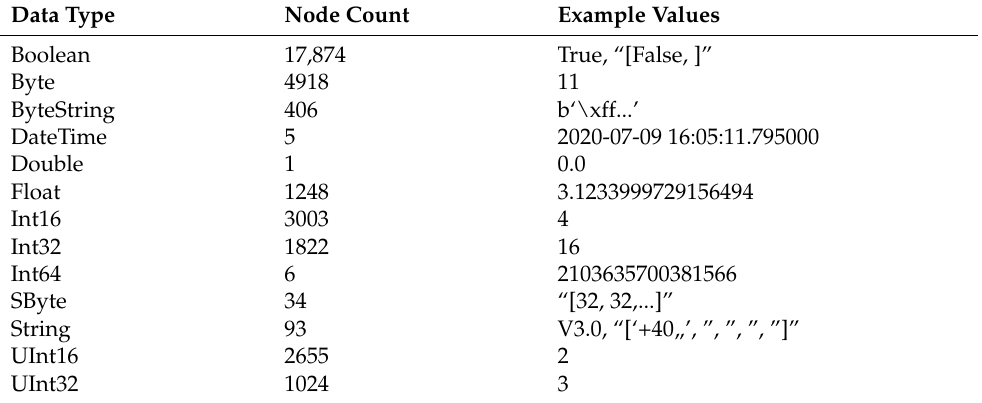
Table 2. Datatypes of all available 33,089 OPC UA Variables with Examples [6]. Reprint with